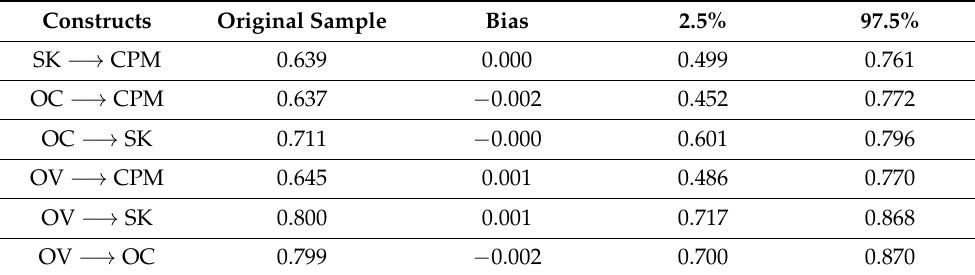
Table 5. Discriminant validity (HTMT): confidence interval bias